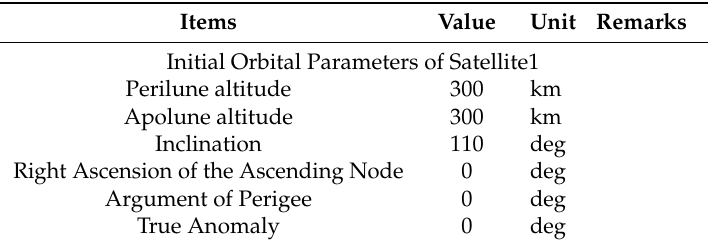
Table 3. Satellite Orbital Parameters Used in the